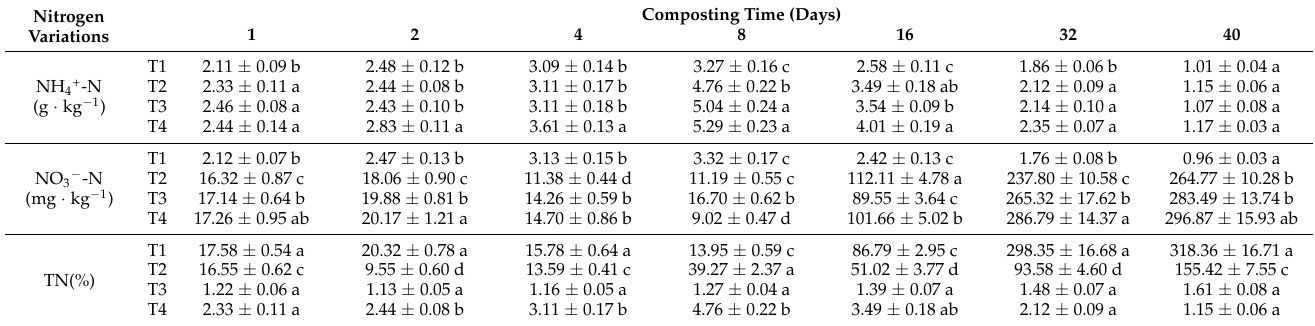
Table 3. Effect of biochar on the change of ammonia nitrogen, nitrate nitrogen, and total nitrogen during